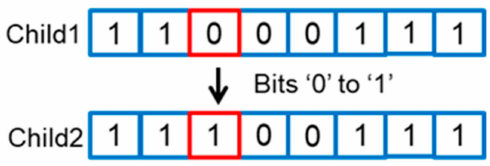
Figure 5. Mutation process of a child.